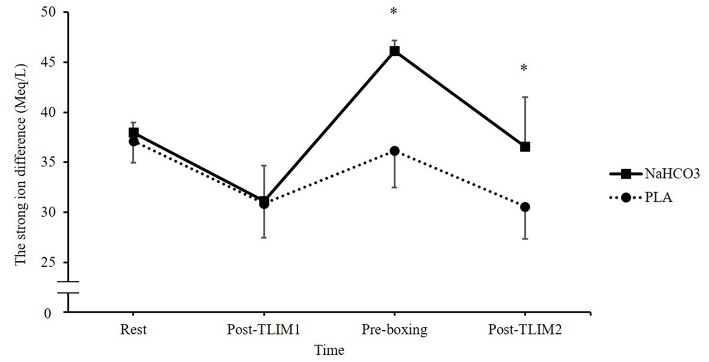
Changes in blood strong ion difference (SID) following NaHCO3 or PLA. *NaHCO3 greater than PLA (p < 0.05).